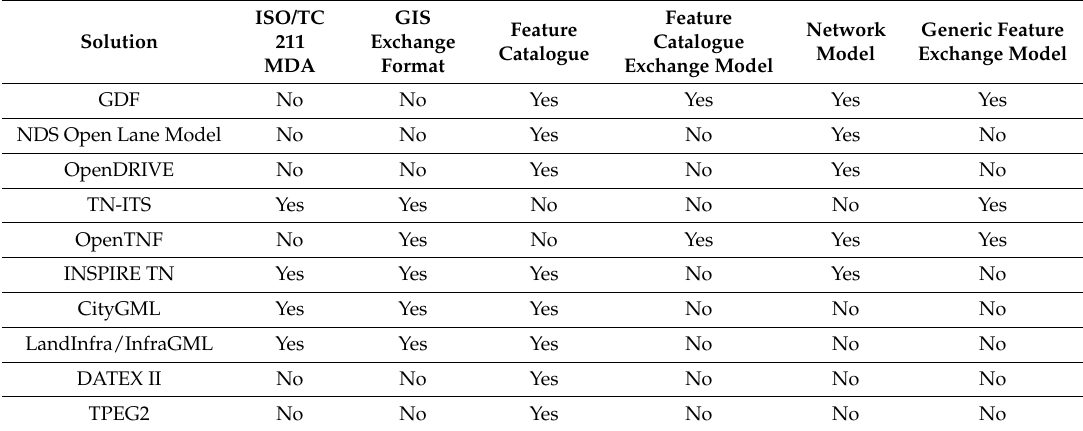
Table 3. Evaluation of studied